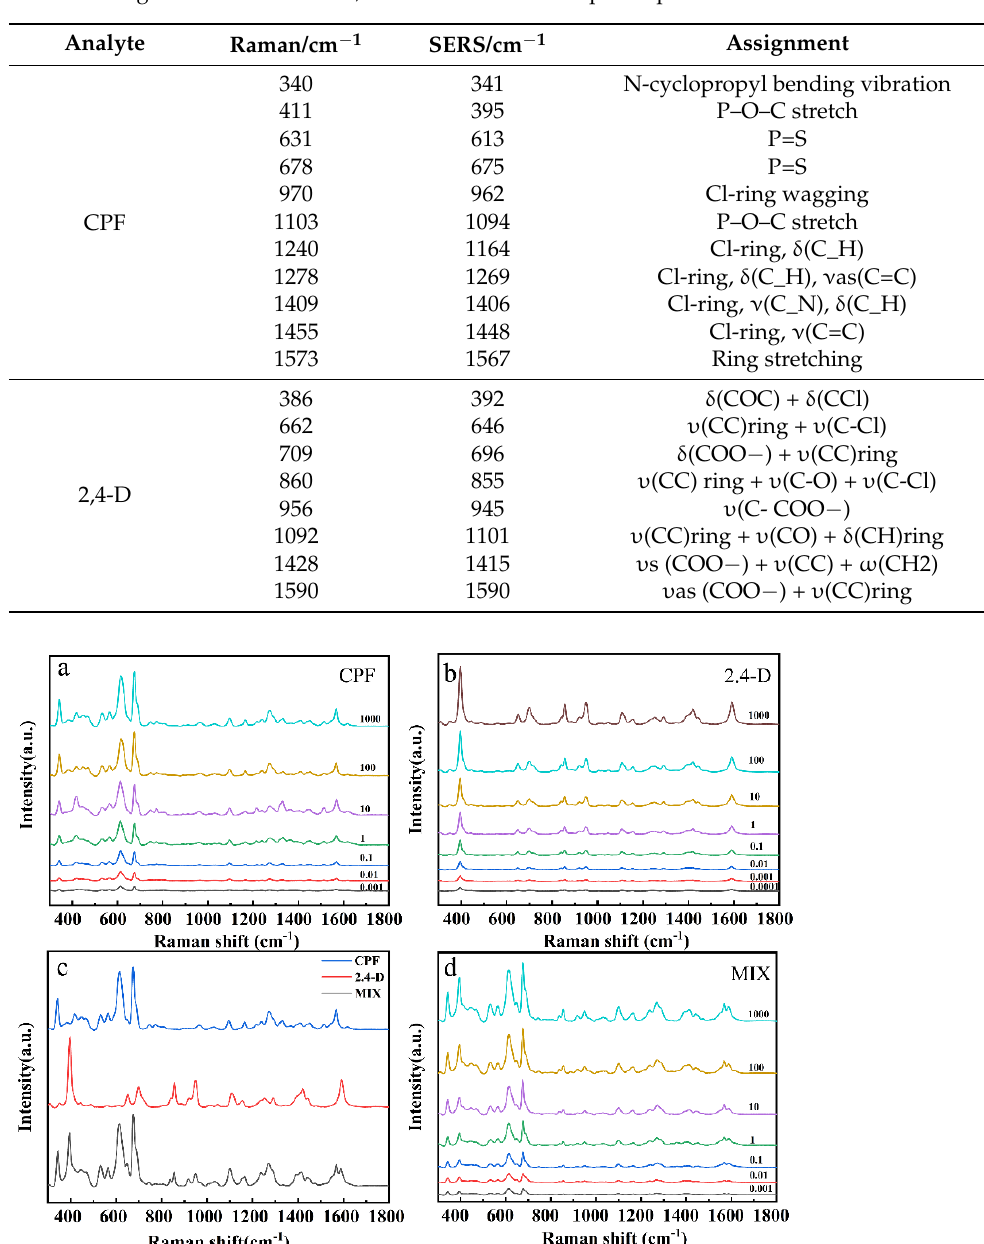
Table 1. Assignments to CPF and 2,4-D Raman and SERS spectra peaks.